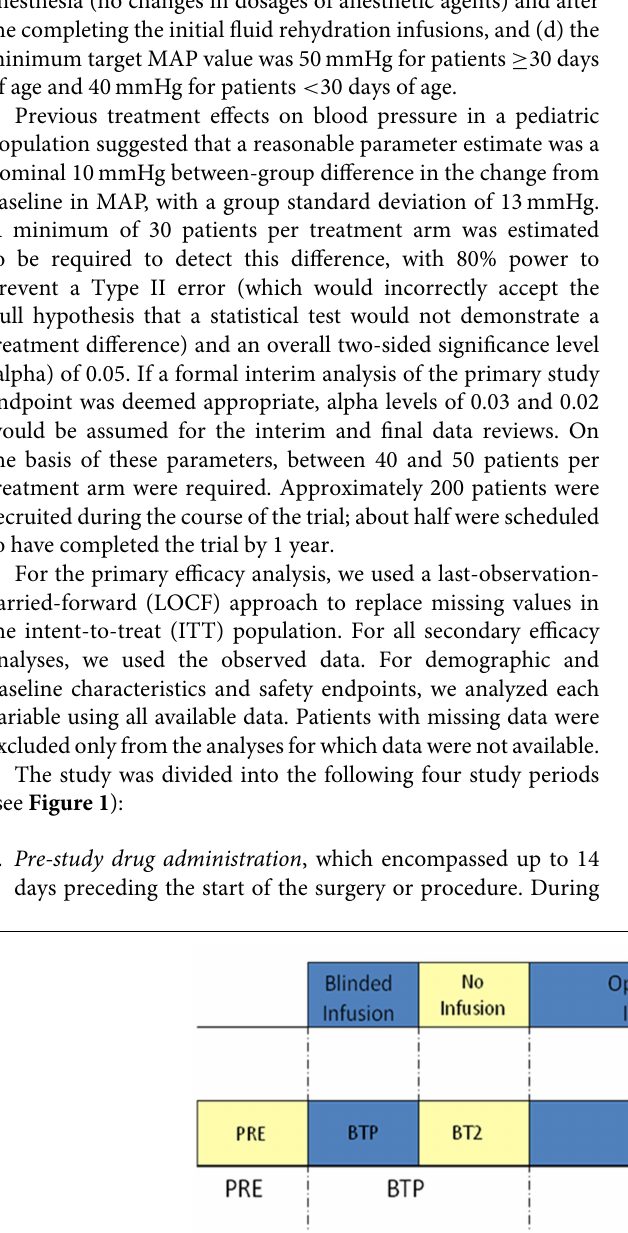
Frontiers in Pharmacology |